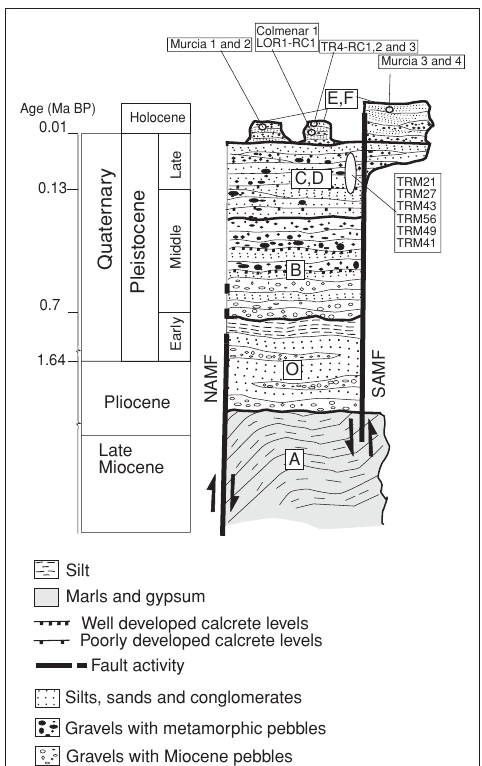
Fig. 3. Stratigraphic column of the Quaternary units differentiated in this work. It is represented the extent of relative outcrop of each unit. The units A and B are restricted to the downthrown block situat- ed between the two main fault branches of the Alhama de Murcia Fault. The southern strand (SAMF) starts its activity in the Late Miocene and affects Holocene deposits of units E and F. The northern strand (NAMF) was active since Early Miocene and decreased its activity during the Quaternary. All the units are labeled with the same letters in fig. 2b, with the exception of unit O that is absent on the map. It was only observed on the ver- tical banks of the creeks. The position of the samples dated with absolute methods is also represented (tables II and